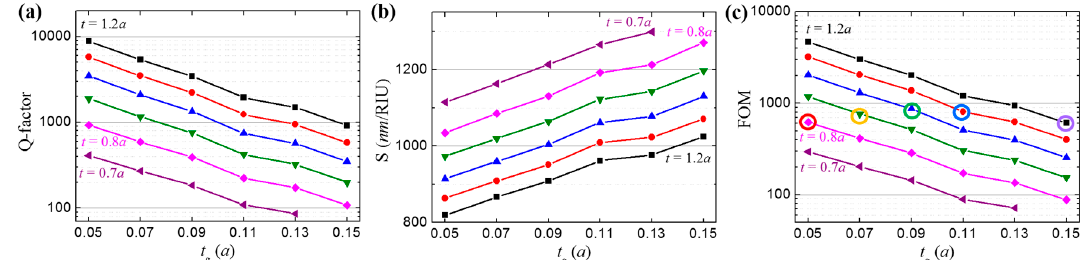
Figure 4. Characteristics of the air gap cavity mode in a PhC NB cavity with various thicknesses ( t ) of 189